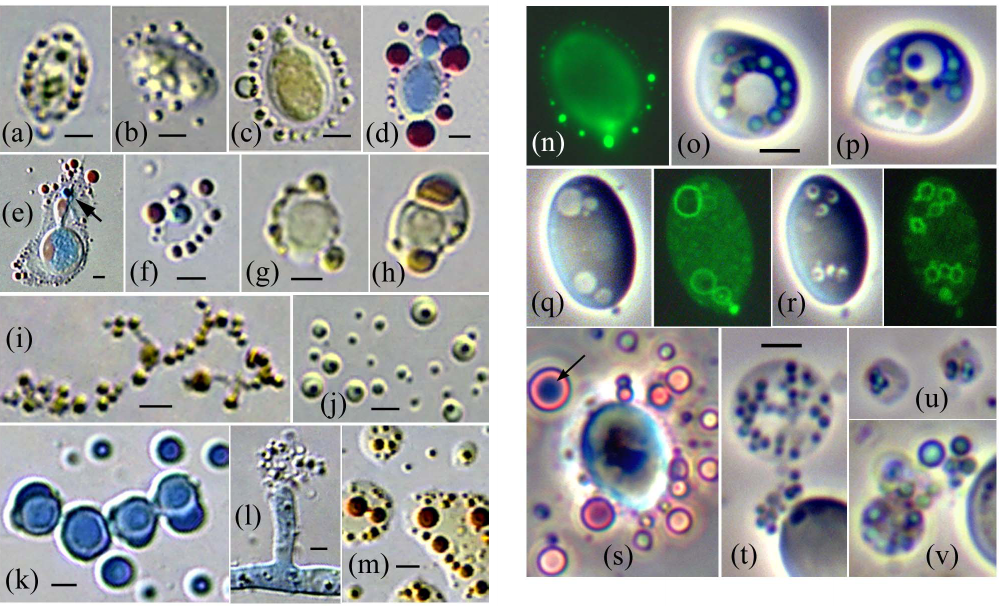
Figure 5. Mycosomes produced by endophytic fungi. Left panel: (a–h) Ms are associated with, or released from modified cell walls. (a–b) Cryptococcus victoriae , MR stain. (c–d) C. stepposus stained with MR (c), and AB/SIV (d). (e) An IAA-treated Taphrina cell enclosed by a thin expanded wall associated with lipoid-Ms and one AB-staining Ms (arrow). (f) An IAA-treated Rhodotorula cell showing a single AB-staining Ms. (g–i) Ms released from Penicillium modified cell walls (g–h) reproduced in chain-like filaments (i). (j) Condensed-Ms (here Cladosporium ) often enlarge as spheroid protoplasts that express a dark punctate body within an internal compartment. (k) Cultured in 2xT864 medium, Penicillium conidia cell walls appear to expand as Ms-forming protoplasts. (l) Young Penicillium filaments released Ms within membrane sacs. (m) Taphrina Ms enlarge as protoplasts that form numerous red-brown bodies within a light-yellow staining compartment (MR stain). Bars =2.0 m m. Right panel: Phase contrast. (n) SYTO 9- stained Ms are released through Aureobasidium cell walls. (o–p) Rhodotorula cells: (o) Refractive lipoid-PMOs surround a vacuole. (p) Presumptive PMOs often contain a Ms-like body. (q–r) Saccharomyces cells express presumptive vacuolate PMOs with SYTO 9-staining boundaries. Note Ms release through the cell wall (q) and non-staining bodies within the PMOs (r). (s–v) Taphrina cells: (s) Lipoid-Ms released from a degraded cell wall (AB/SIV stain); (t) Type I protoplasts contain numerous dividing bodies, possibly PMOs; (u–v) the presumptive PMOs show refractive lipids (u), and are apparently incorporated into buds that form Type II lipoid-Ms (v). Bars in (o) and (t) =2.0 m m in all